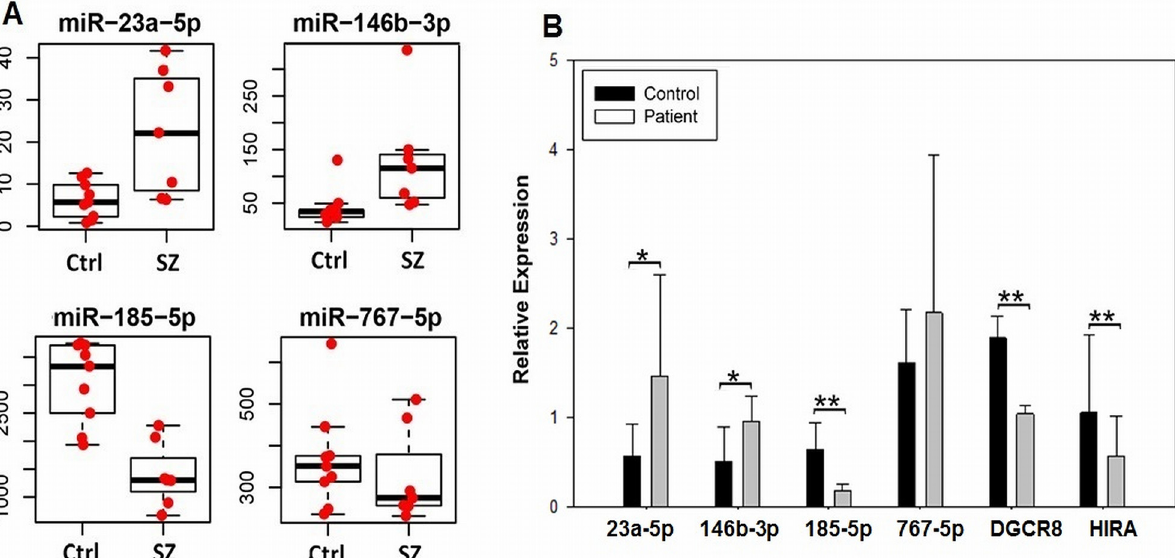
Fig 2. A. miRNA-seq reads (y-axis) for controls (ctrl) and patients with 22q11.2 del (SZ) showing two, nominally significant up-regulated genes (miR-23a-5p and miR-146b-3p), a miRNA that showed a genome wide significant decrease in expression (miR-185-5p), and a miRNA that showed no difference in expression (miR-767-5p). B. Same miRNAs in 2A showing qPCR analysis using Mercury LNA Universal RT microRNAs assays, as described in methods. The relative expression of two coding genes that map to the 22q11.2 del region ( DGCR and HIRA ) was analyzed by routine qPCR. A Student ’ s t-test was used for statistical analysis. Error bars show standard deviation; p < 0.05, one-tailed * ; p < 0.05, two-tailed. **